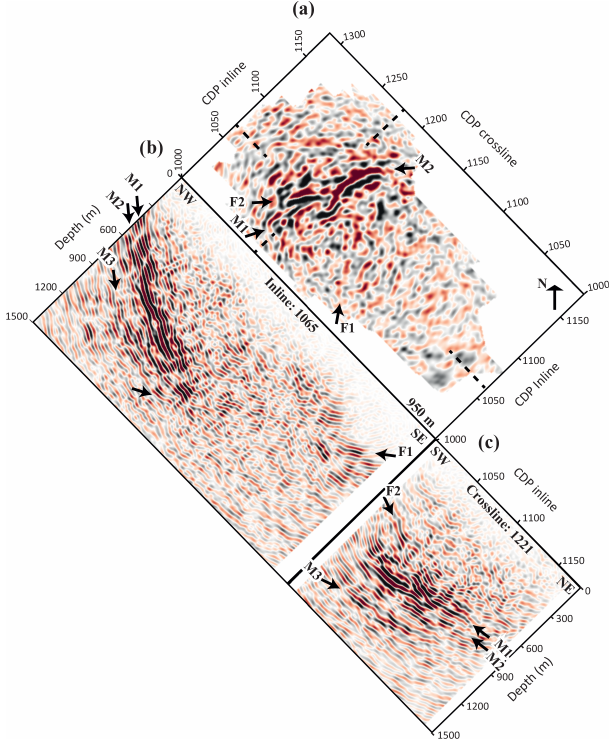
Figure 11. A series of slices. (a) Depth slice, (b) inline, and (c) crossline through the migrated and time-to-depth-converted stacked volume showing two major sets of southeast-dipping reflections (M1 and M2) terminated by a northwest-dipping one (F1). The crossline section shows these two sets of reflections have gentle but different dips towards the west. The F2 reflection appears to sub- merge (downlap) with M1. In the footwall of M1 and M2, another submerging reflection (M3) appears, although it is